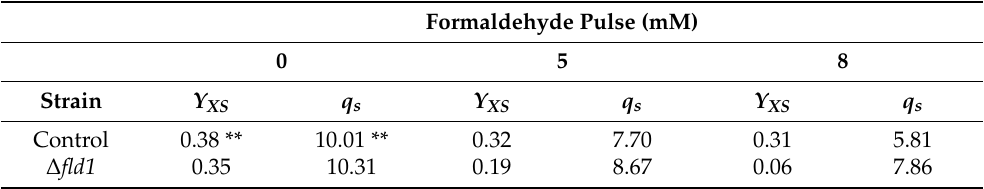
Table 2. Effect FLD1 gene deletion on yield of methanol into biomass and the specific consumption rate of methanol *.